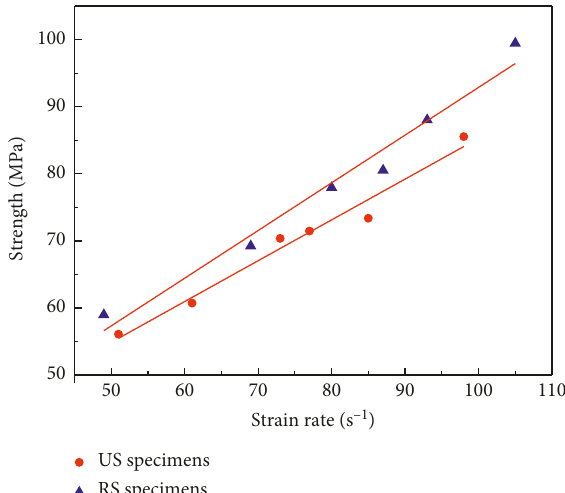
Figure 7: Dynamic strength under different strain rates.